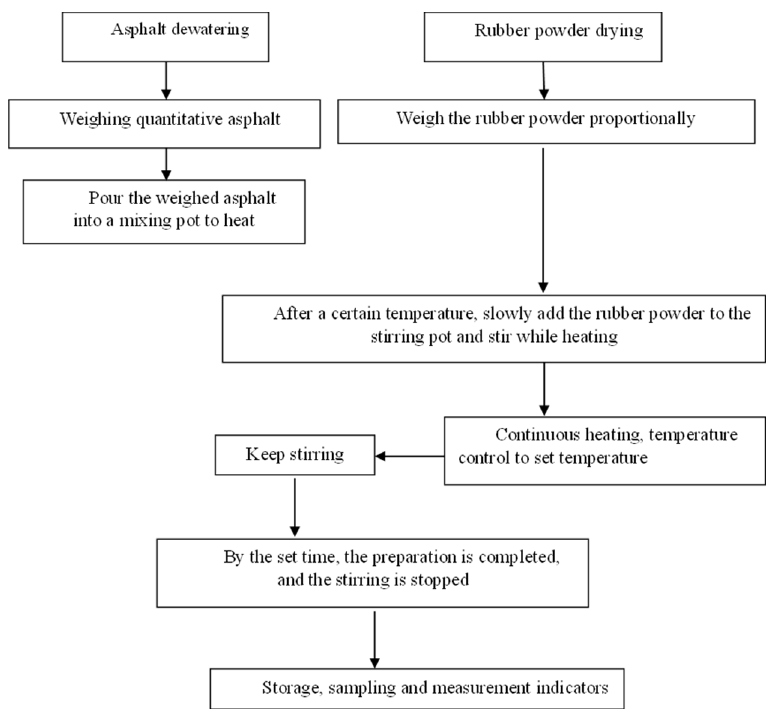
Figure 2. Asphalt rubber preparation process.